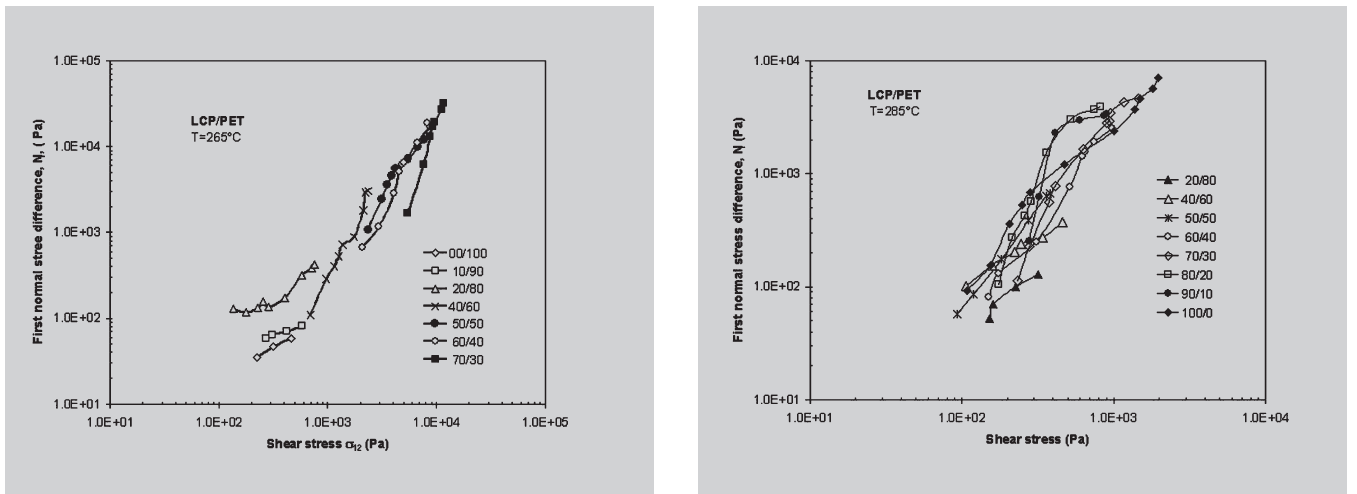
Figure 13 (left): Variation in first normal stress difference,N LCP/PET blend with shear stress at 265°C. Figure 14: Variation in first normal stress difference,N LCP/PET blend with shear stress at